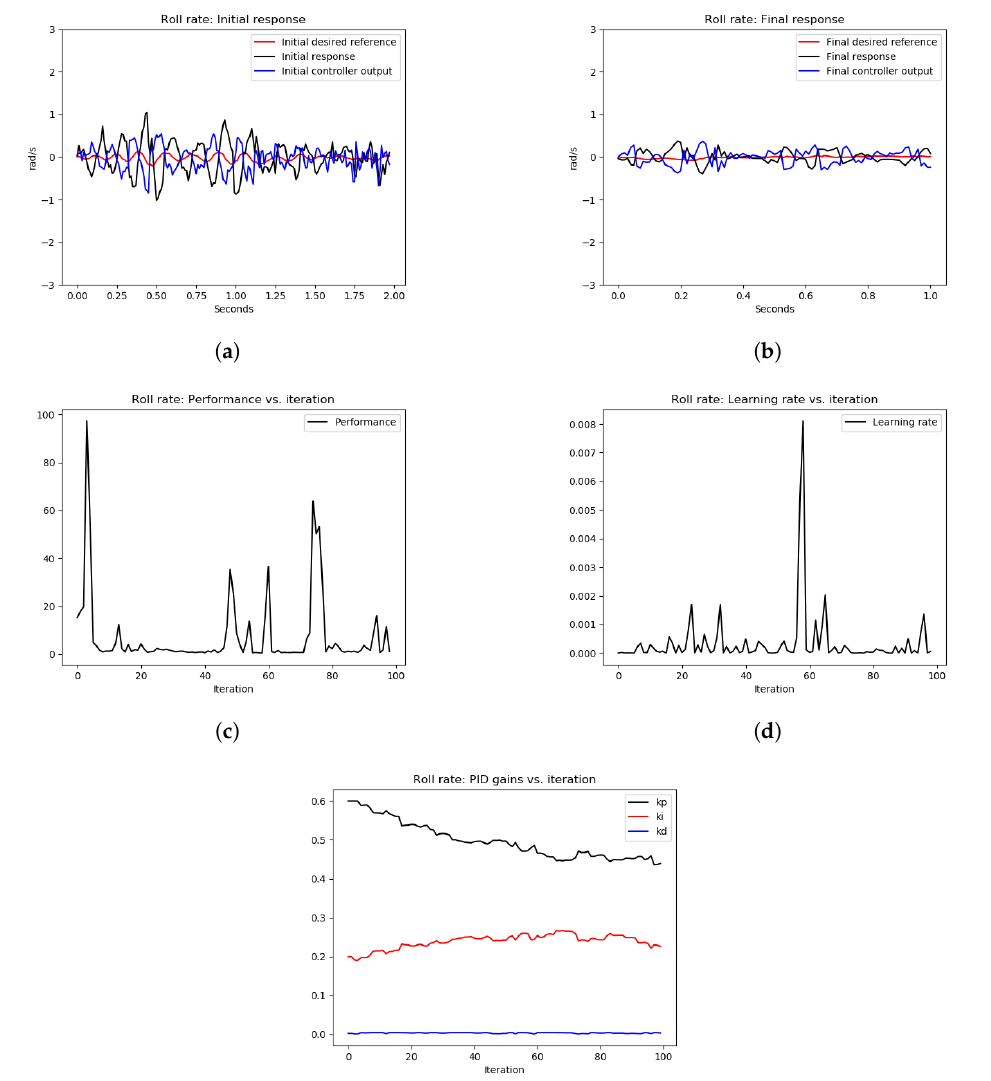
Figure 14. The results of the tuning process of the roll-rate PID controller in Experiment 2. ( a ) signals before tuning, ( b ) signals after tuning, ( c ) performance error V ( E ) over iterations, ( d ) learning rate α over tuning iterations, ( e ) PID gains.